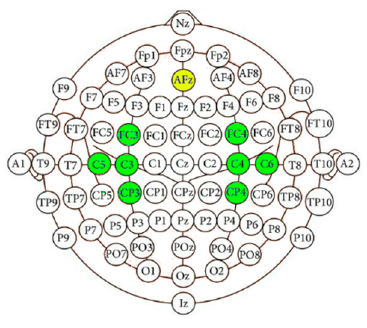
Figure 4. The EEG electrodes positions adopted in our study.